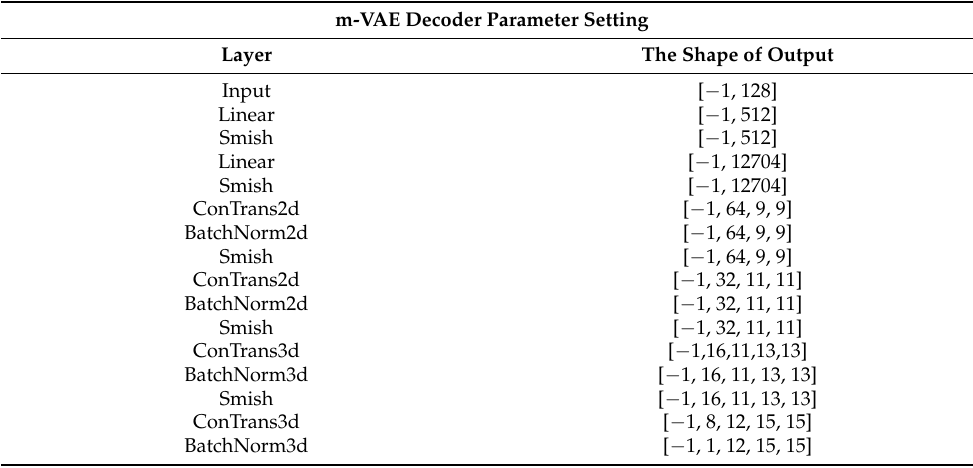
Table 9. The shape of layers in the m-VAE model for